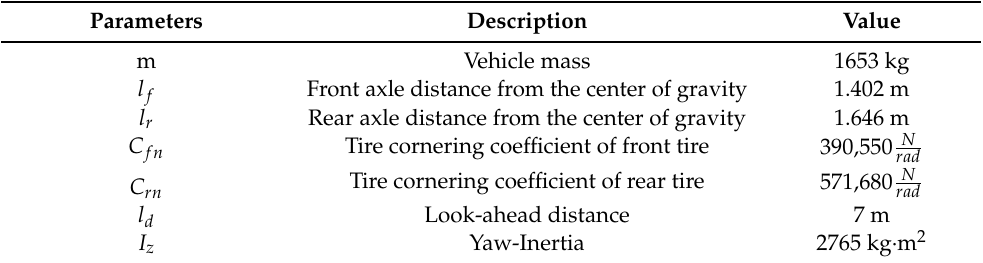
Table 1. Vehicle specifications.